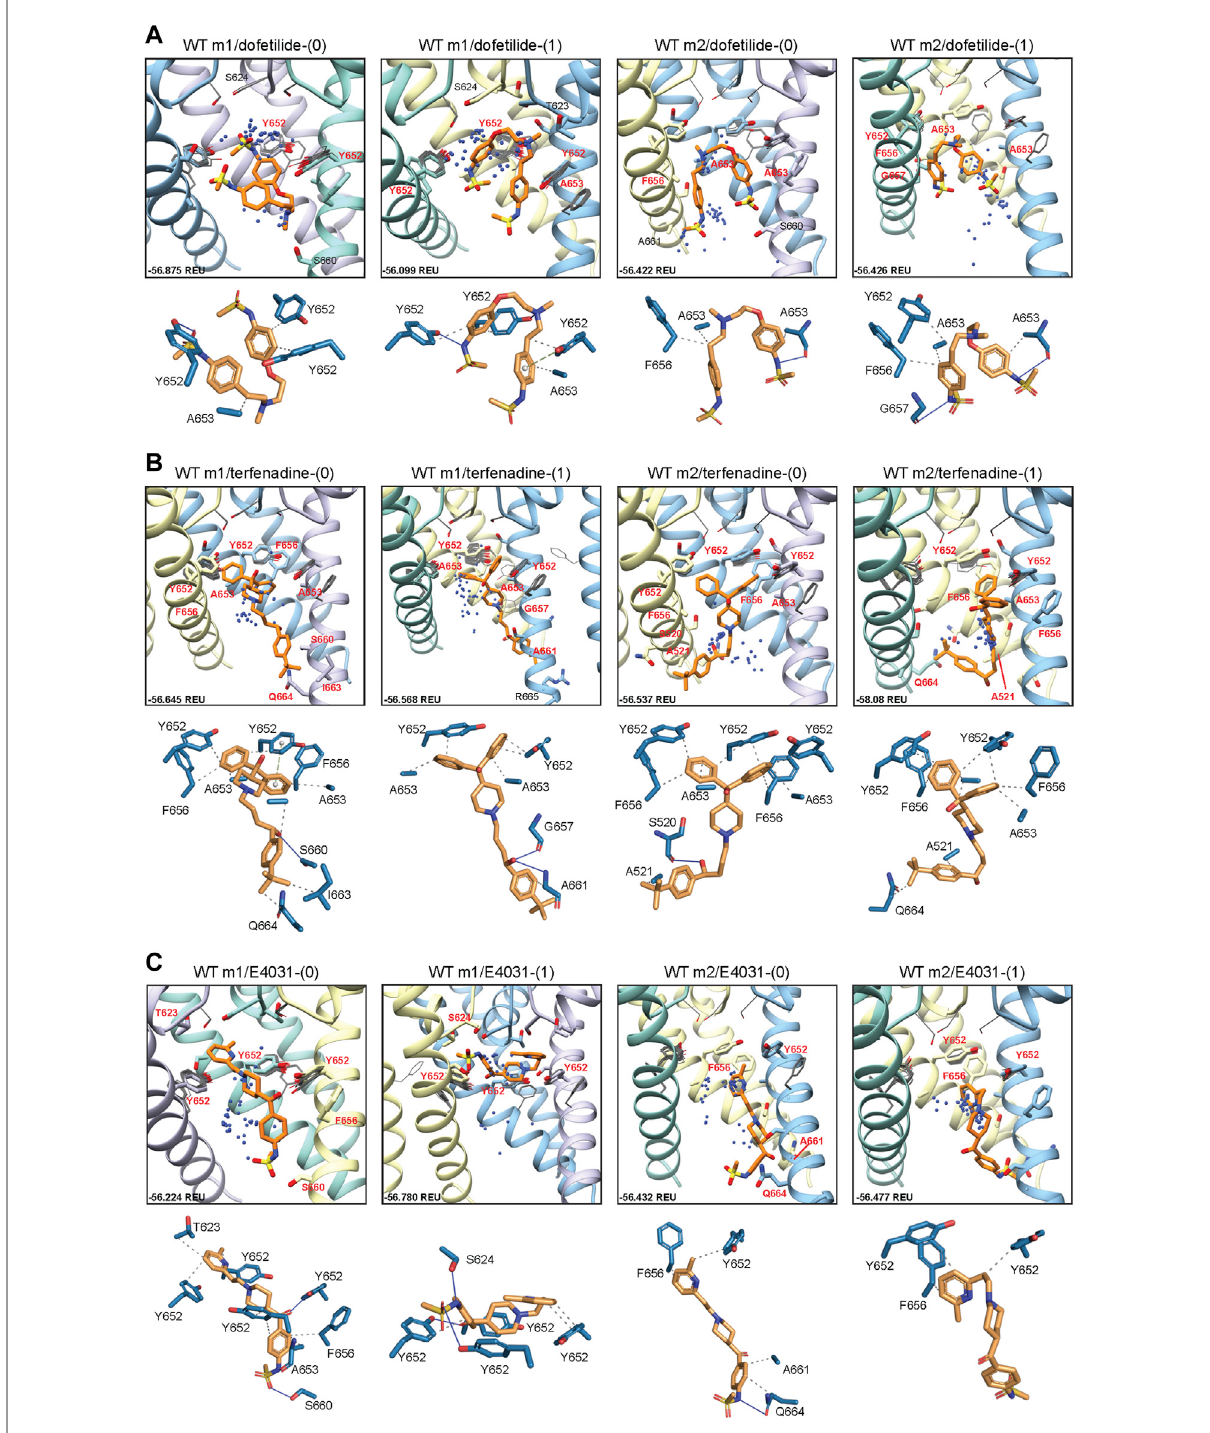
FIGURE 2 hERG WT drug docking results for (A) dofetilide, (B) terfenadine and (C) E4031. Boxes show results of ligand docking to hERG WT model 1 ( “ WT m1 ” ) and model 2 ( “ WT m2 ” ) for neutral ( “ (0) ” ) and charged ( “ (1) ” ) form of each ligand (dofetilide, terfenadine, and E4031). Boxes represent top 50scoringstructures,withtop-scoringstructureasorangesticks(forcarbonatoms)andremainingstructures asbluecentroidsrepresenting central nitrogen/charge group of the respective compound. Oxygen atoms are colored red, nitrogen — blue, sulfur — yellow. Hydrogens are not shown for clarity. Residue contacts to top-scoring structures are shown as sticks and labeled in bold red; residue contacts for all other ligands are shown as gray wires. Chains are colored as in Figure 1. Rosetta ligand interface score for each top-scoring structure is shown in Rosetta energy units (REU)